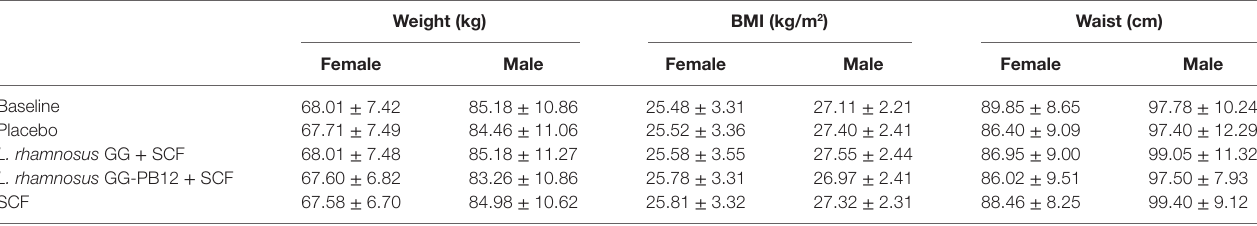
TaBlE 2 | Change in anthropometric measurements in all study participants ( n = 37) between baseline and 3 weeks intervention period with placebo (maltodextrin), Lactobacillus rhamnosus GG